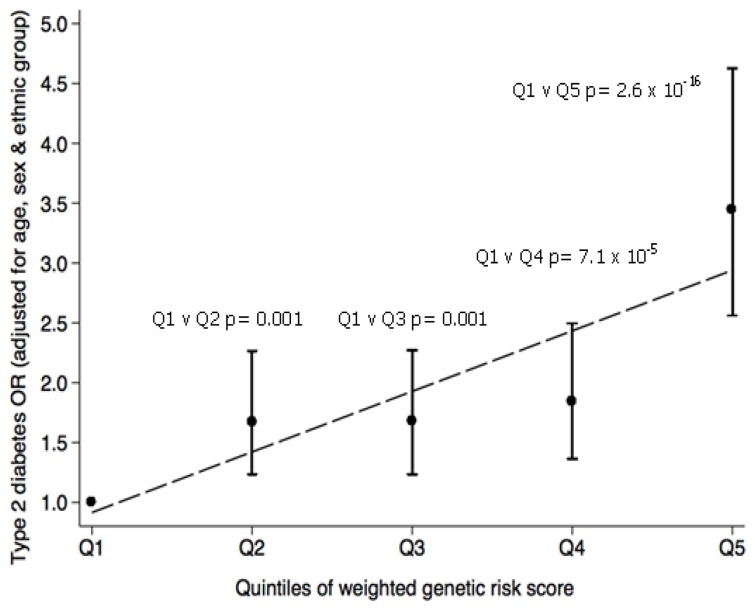
The combined impact of the 36 T2D-associated SNPs on T2D risk in T2D cases and controls of South Asian origin from Sri Lanka.Subjects were grouped into quintiles of the weighted genetic risk score. Circles represent the T2D odds ratio (adjusted for age, sex and ethnic group) when comparing each quintile group to the group in the lowest quintile (Q1). The capped lines represent the 95% CI of the T2D odds ratios.